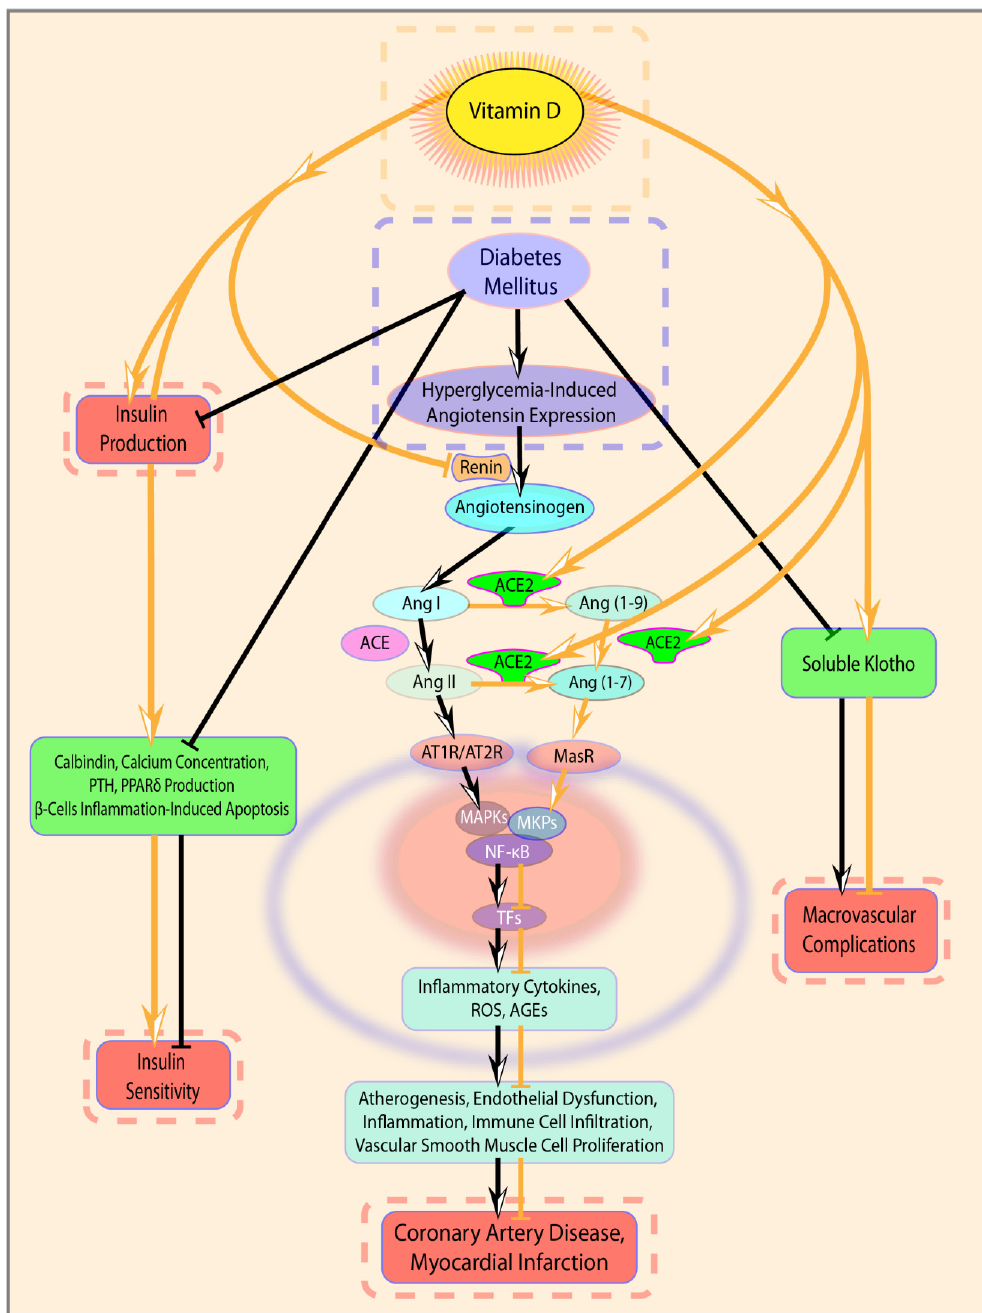
Figure 3. Schematic highlighting of the potential interaction between VitD and DM and the resulting negative e ff ects in coronary artery disease (CAD) pathogenesis and progression. Legend: Angiotensin converting enzyme (ACE); Angiotensin converting enzyme 2 (ACE2); Angiotensin I (Ang I); angiotensin II (Ang II); angiotensin 1–7 (Ang 1–7); Ang II type 1 receptor (AT1R); Ang II type 2 receptor (AT2R); MAS receptor 1 (MAS1); mitogen-activated protein kinase phosphatase (MKPs); mitogen-activated protein kinases (MAPKs); nuclear factor kappa-light-chain-enhancer of activated B cells (NF-kB); transcription factors (TFs); Reactive oxygen species (ROS); advanced glycated end products